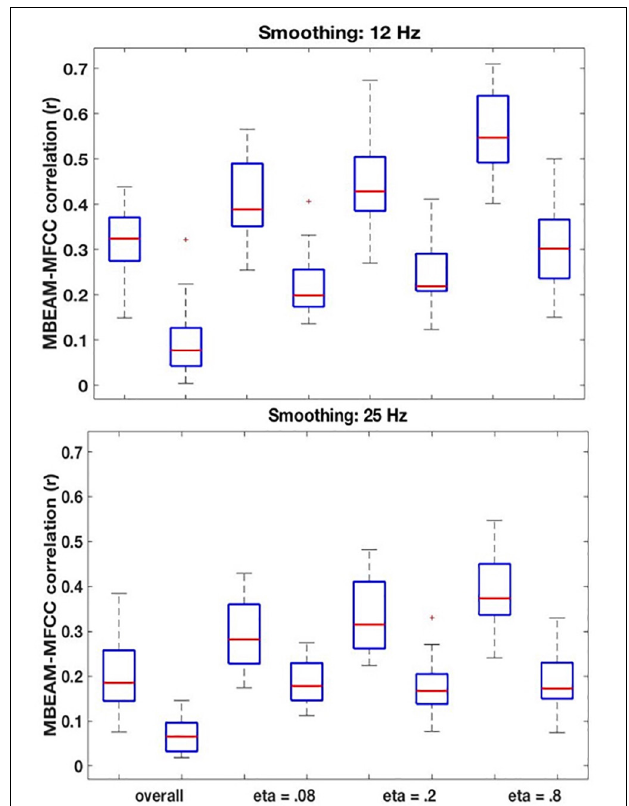
FIGURE 6 | (Top) Box plots comparing correlations between the original MBEAM and MFCC modulation functions filtered at 12 Hz and the correlations of the corresponding surrogate data functions, for four different correlation types: the overall correlation and the median values of the CMA correlation function for three different values of η . For each of the correlation types, the original data is plotted on the left and the surrogate data on the right. In all cases, the absolute values of the correlations are plotted. (Bottom) Same plots as top , for modulation functions filtered at 25